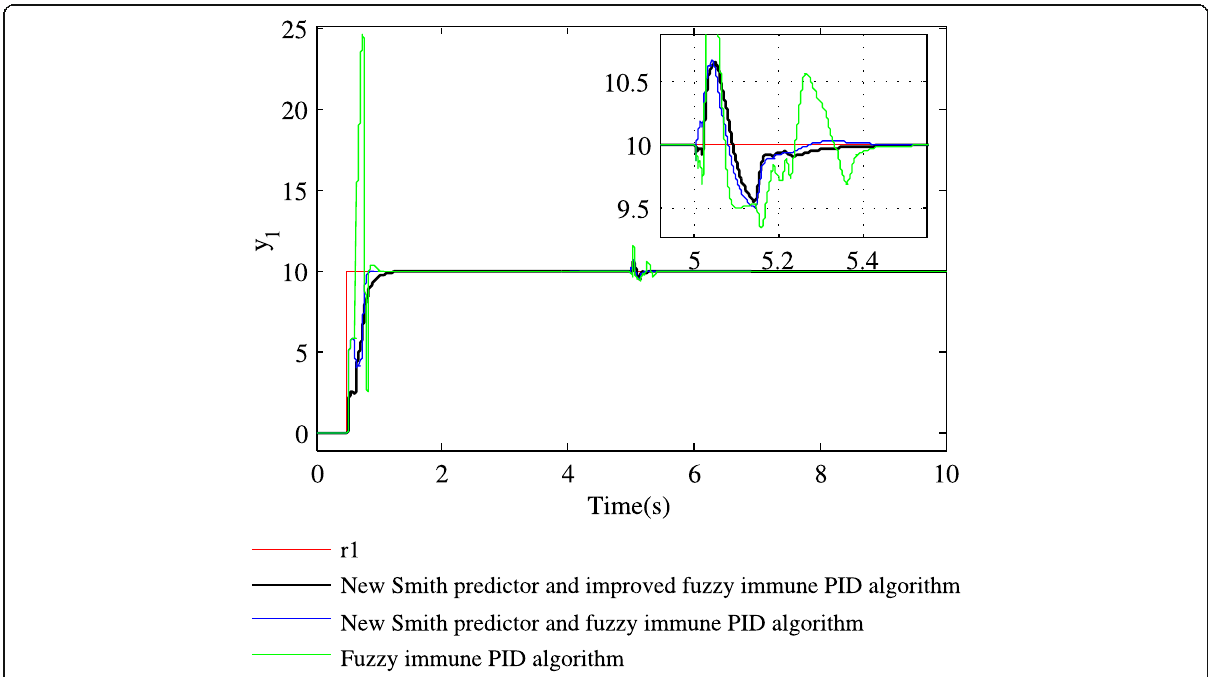
Fig. 9 The step responses of loop 1 when the model matches the generalized plant